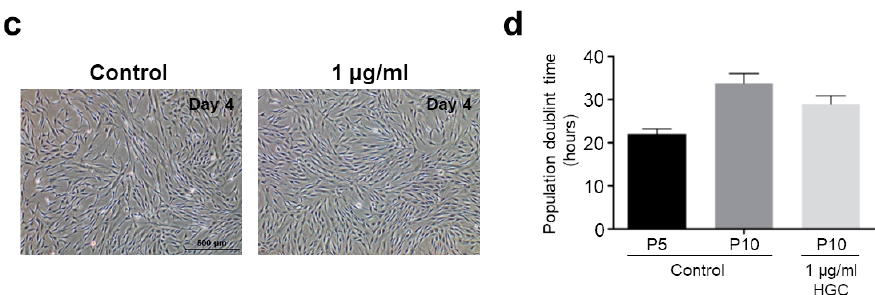
Figure 3. Investigation of optimal hexanoyl glycol chitosan (HGC) concentration. ( a ) experimental scheme; ( b ) cell number of AD-MSCs at day four (passage 5); ** p < 0.01 relative to the control; ( c ) cell morphology and density of the control and 1 μ g/mL of HGC at day four (passage 5); ( d ) Comparison of population doubling time at passage 5 (the control) and the control and 1 μ g/mL of HGC group at passage 10.